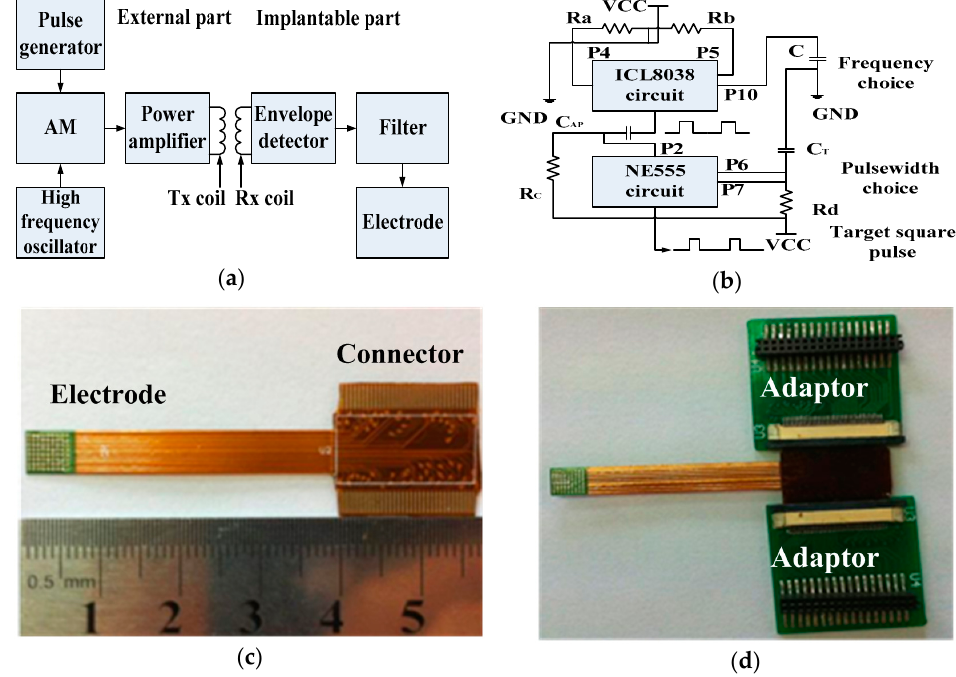
Figure 4. ( a ) The principle diagram of implantable single-channel stimulation system. The external part includes a pulse generation and transmission circuit array, and the implanted part includes a microcoil, demodulated circuit, and surface electrodes; ( b ) The schematics of the two-stage pulse generator circuit. The first stage circuit using ICL8038 is responsible for target frequency adjustment. The second stage circuit using NE555 is responsible for target pulse width regulation; Supply voltage (“VCC”); Ground (“GND”); ( c ) The surface micro-electrode array manufactured by six-layer flexible printed circuit (FPC) technique. The implantable part included 72 microelectrodes in about 5 × 5 mm 2 area. The connecter part was connected to an independent external stimulator. It was finally abandoned due to high stiffness; ( d ) The electrode array has two bigger adaptor boards to connect the external stimulator. It was finally abandoned due to the size of the adaptor.